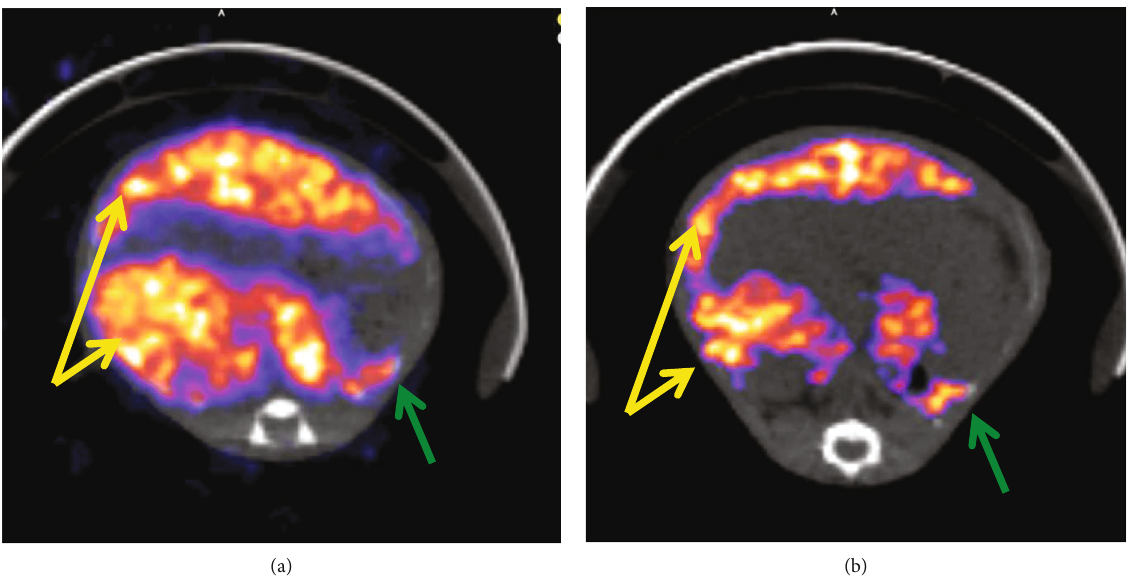
Figure 6: SPECT/CT imaging (NanoSPECT/CT, Mediso) of a mouse at 10min p.i. (a) and a mouse at 60min p.i. (b), showing accumulation in the liver (yellow arrows) and in the spleen (green arrows). Both mice were injected iv (tail vein), euthanized at the speci fi c time points, and imaged fi rstly on SPECT/CT and directly after on MRI (Figures 2 –